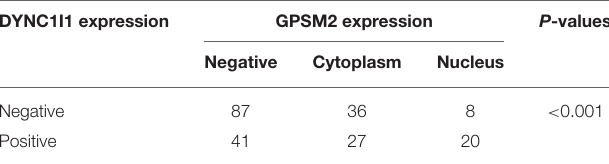
TABLE 5 | Correlations between GPSM2 and DYNC1I1 expression levels in patients with breast